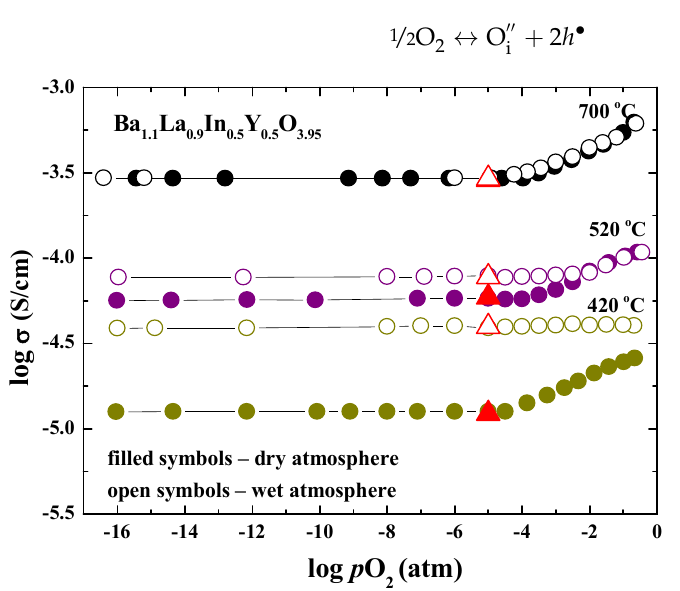
Figure 8. The total conductivity vs. p O 2 for the composition Ba 1.1 La 0.9 Y 0.5 In 0.5 O 3.95 at dry (filled symbols) and wet (open symbols) conditions; and conductivity values from σ –10 3 / T dependencies at dry Ar (red symbols).